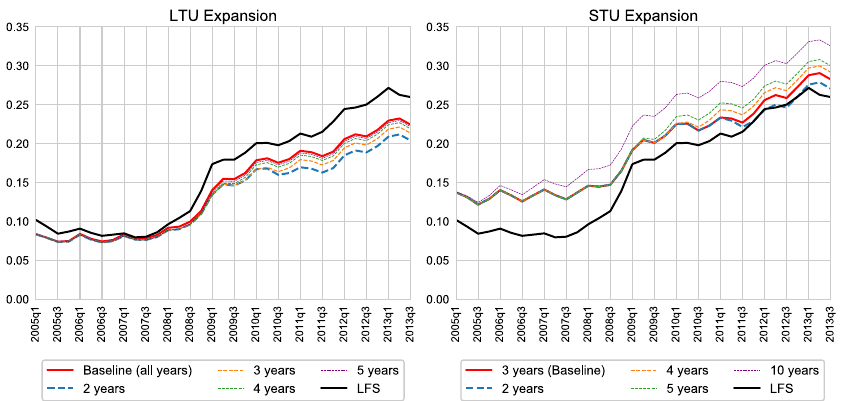
Fig. 13 Maximum duration of expanded unfinished spells, by expansion. Source : MCVL and the